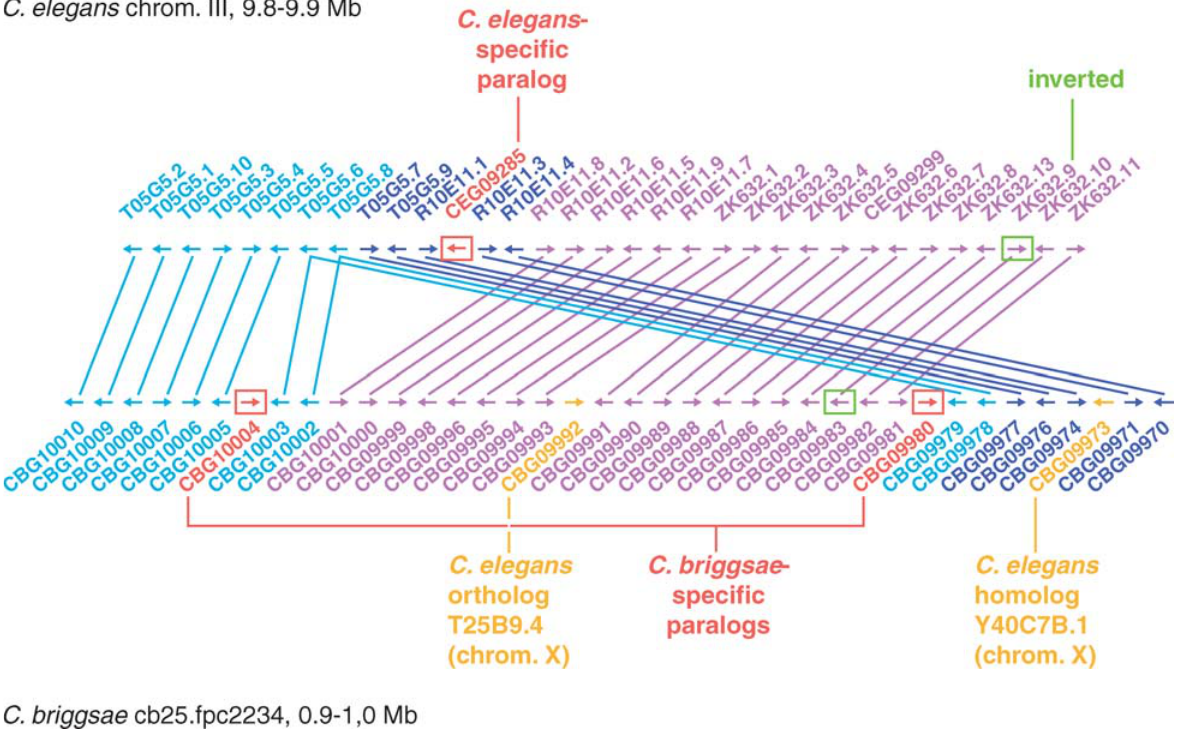
Figure 7. A Region on C. elegans Chromosome III Containing 33 Genes, and the Syntenic C. briggsae Region, Which Has 38 Genes Inversions have broken the syntenic region into three conserved segments. Genes that do not have an ortholog in this syntenic region are in grey; orthologs are joined by lines. In C. elegans , genes that differ substantially in structure between the WS77 and hybrid gene sets are marked with an asterisk. DOI: